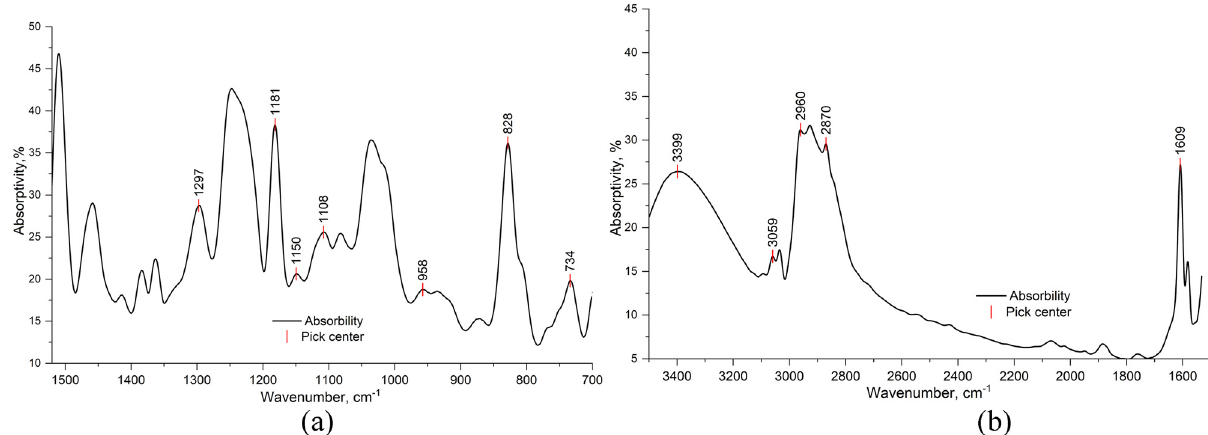
Figure 1: Infrared spectrum zones of ( a ) fi ngerprint and ( b ) overtone of epoxy resin specimen without quenching treatment.